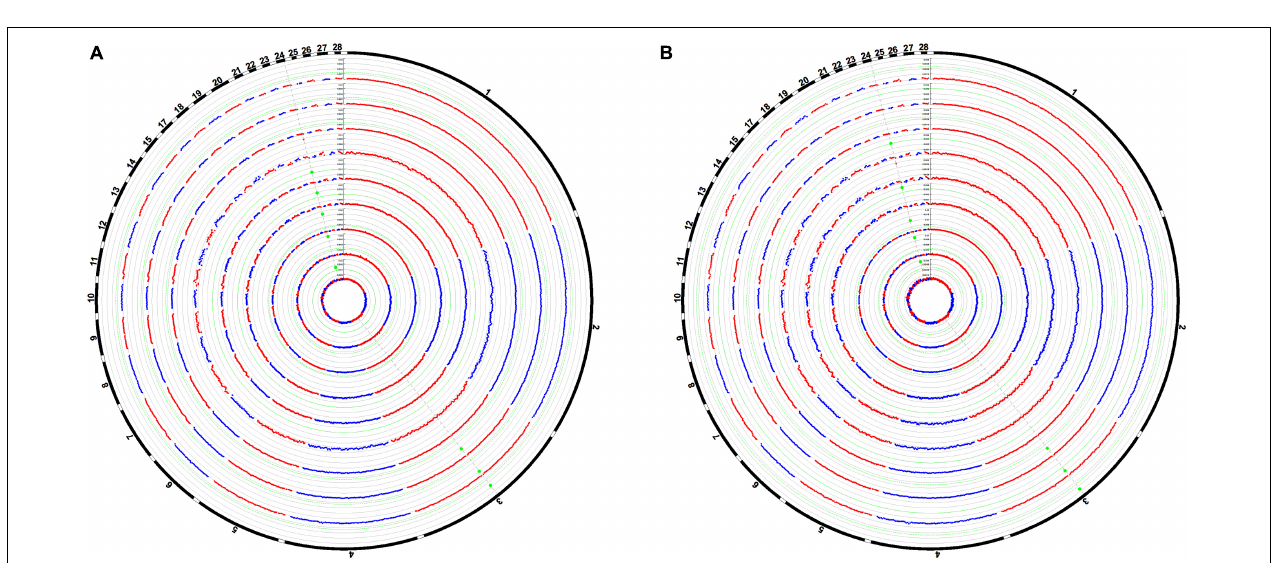
FIGURE 4 | Manhattan plots of the average proportion of genetic variance (A) and phenotypic variance (B) explained by the 1-Mb window for all traits. Each dot represents a 1-Mb window. The circle Manhattan plots from the inside to the outside are BW42, CW, EW, WThW, ThW, ThMW, WThP, ThP, and ThMP. The dotted green lines indicate the 1.00% threshold of genetic variance and the 0.30% threshold of the phenotypic variance explained by the windows.